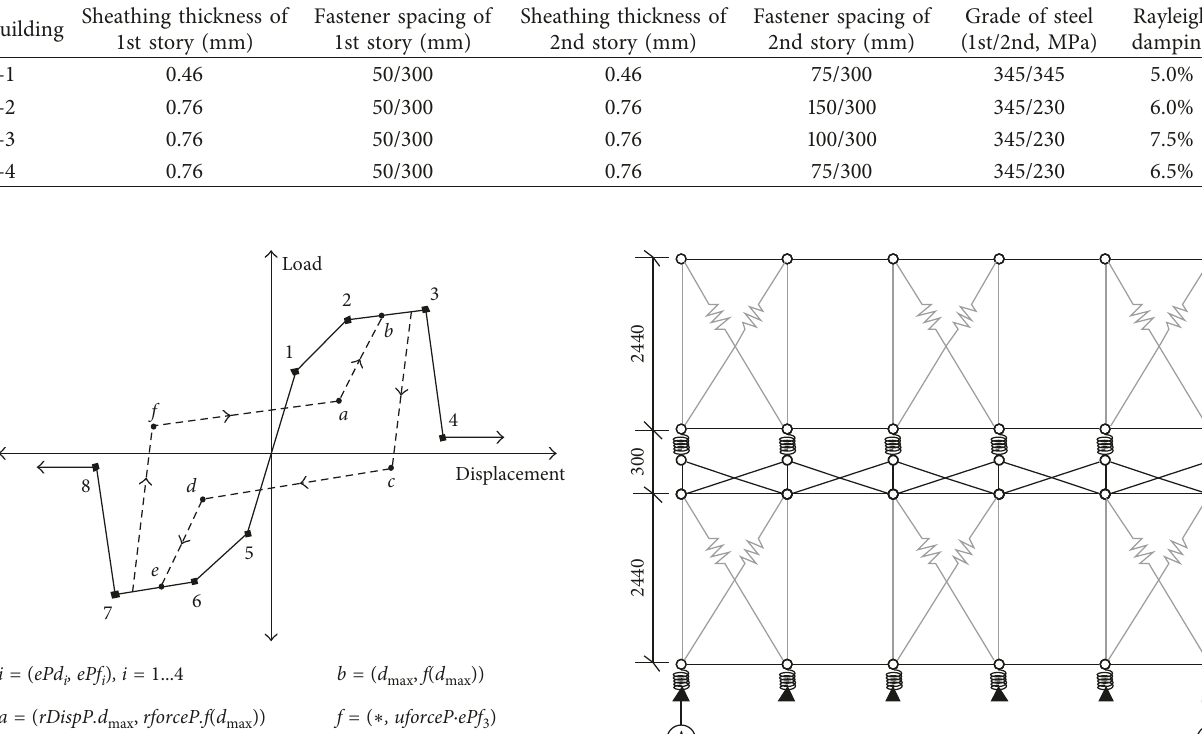
Table 1: Wall configurations of the CFSF buildings.